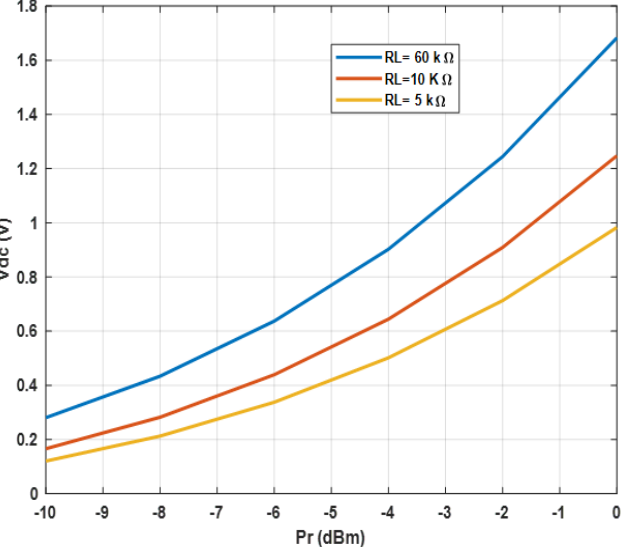
Figure 26. Output voltage at the load for different R L and P r , for the rectifier circuit in Approach II.